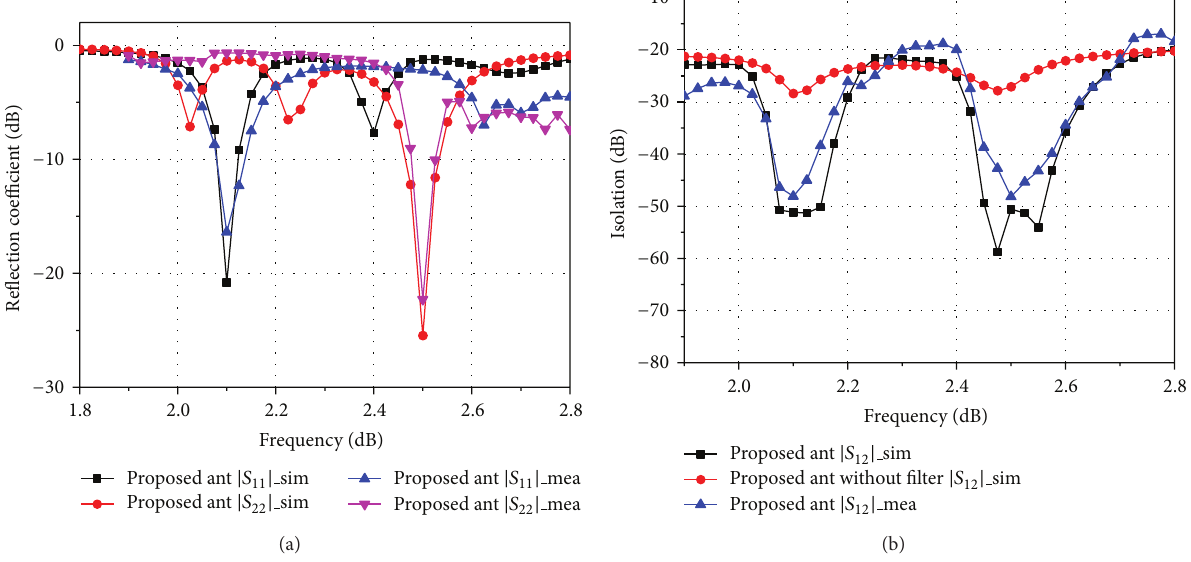
Figure 6: Measured and simulated 𝑆 parameters of DEP-EBG filters antenna. (a) Reflection coefficient. (b)